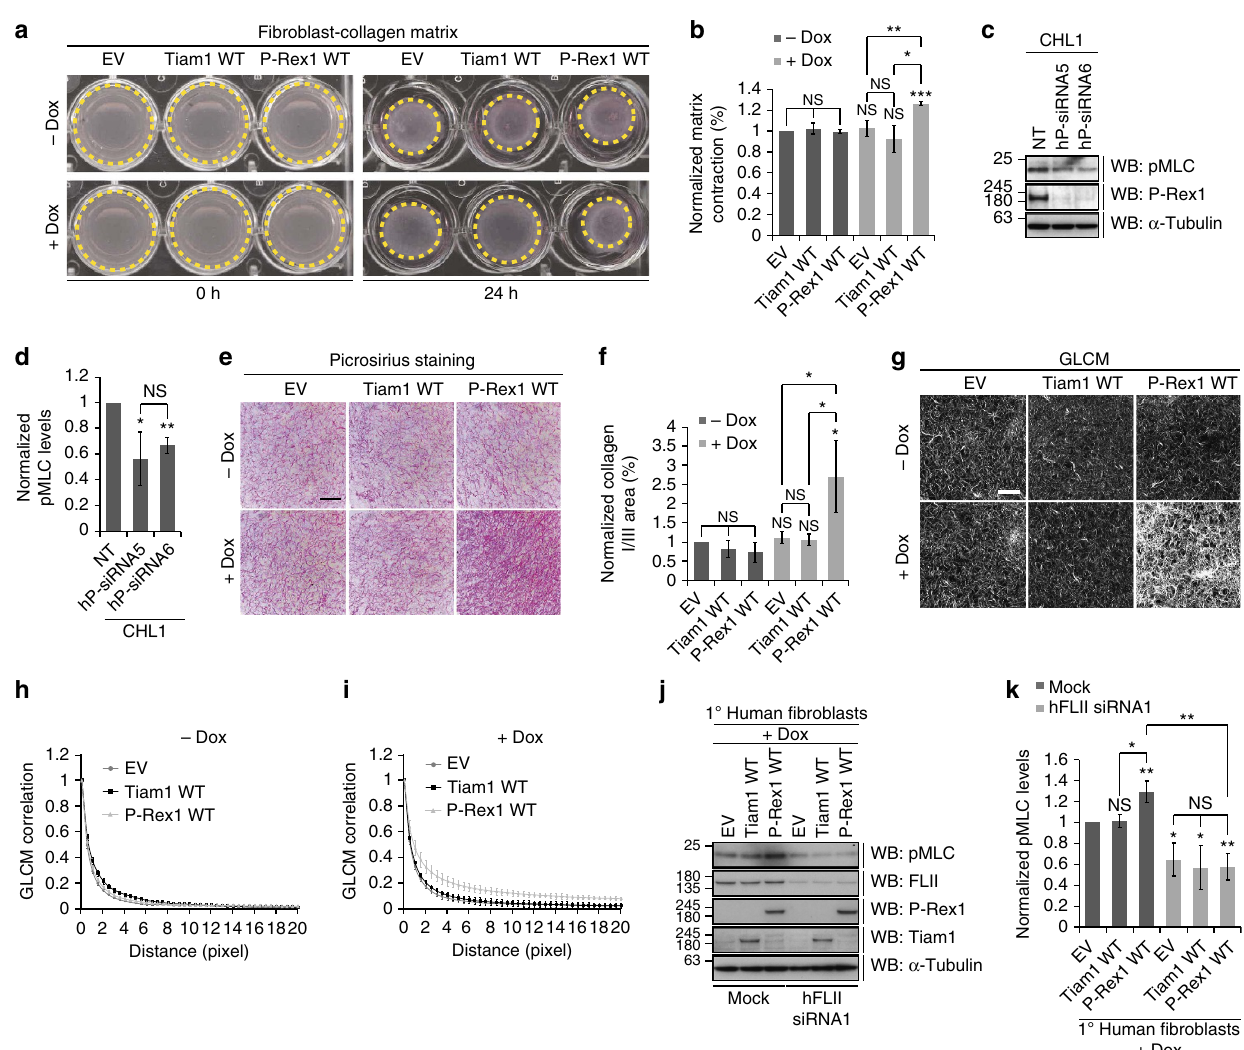
Figure 7 | FLII is required for P-Rex1-driven cell contraction. ( a ) Fibroblast-collagen matrices were treated with ethanol ( (cid:2) dox) or 1 m gml (cid:2) 1 doxycycline ( þ dox) to induce expression of indicated constructs and scans were taken at 0 and 24h post treatment. ( b ) Quantification of cell contraction depicted in a normalized to (cid:2) dox treated EV control. Graph represents the average per cent matrix contraction ± s.e.m. from three independent experiments. ( c ) CHL1 cells were transfected with NT, or two different siRNAs against human P-Rex1 (hP-siRNA5, hP-siRNA6). Levels of endogenous pMLC and P-Rex1 were detected by western blot analysis. ( d ) Quantification of pMLC levels in CHL1 cells described in c normalized to a -Tubulin and pMLC levels detected in the NTcontrol. Graph represents average pMLC levels ± s.e.m. from three independent experiments. ( e ) Collagen picrosirius staining of matrices described in a . Scale bar, 50 m m. ( f ) Quantification of picrosirius staining depicted in e normalized to (cid:2) dox treated EV control. Graph represents the area covered by collagen I and III ± s.e.m. from three independent experiments. ( g ) Representative GLCM images of matrices described in a . Scale bar, 100 m m. ( h , i ) GLCM correlation decay curves of matrices described in a showing (cid:2) dox ( h ) and þ dox ( i ) curves. ( j ) 1 (cid:2) human fibroblasts were either mock transfected or treated with siRNA against human FLII (hFLII siRNA1) in the presence of dox to induce expression of indicated constructs. Levels of endogenous pMLC and FLII were detected by western blot analysis. For c , j , a -Tubulin was used as a loading control. ( k ) Quantification of pMLC levels in 1 (cid:2) human fibroblasts described in j normalized to a -Tubulin and pMLC levels detected in the EV control. Graph represents average pMLC levels ± s.e.m. from three independent experiments. For b , d , f , k , Student’s t -test was used to assess significance as indicated on graphs. P values indicated above each bar are relative to (cid:2) dox treated EV control ( b , f ), NT control ( d ) or mock treated EV control ( k ). NS, non-significant; * ¼ P r 0.05; ** ¼ P r 0.01; *** ¼ P r fibroblast-collagen matrices following 9 days of GEF expression to WT-induced MLC phosphorylation (Fig. 7j,k). This data examine changes in collagen remodelling. As suggested by the highlights a FLII-dependent role of P-Rex1 in regulating cell picrosirius staining and SHG imaging, expression of P-Rex1 WT contraction, thus uncovering a novel signalling cascade by which but not Tiam1 WT was associated with increased collagen P-Rex1 can mediate Rac1-driven cell migration through FLII. crosslinking and remodelling (Fig. 7g–i). We next examined the dependency of P-Rex1-mediated cell contraction on FLII. Cell contraction regulates P-Rex1-driven cell migration . To was associated with an overall reduction in pMLC levels further explore the role of cell contractility in P-Rex1-Rac1-FLII- regardless of which construct was expressed. More importantly, driven cell migration we performed ORIS migration assays using FLII knockdown in P-Rex1 WT expressing cells inhibited P-Rex1 NIH3T3 cells expressing P-Rex1 WT upon dox induction that